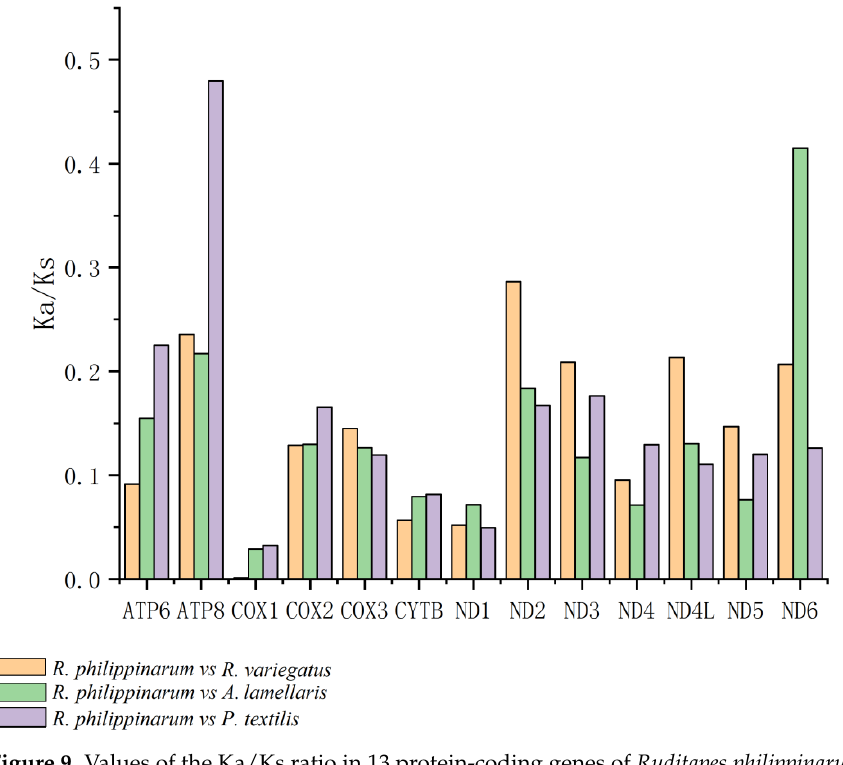
Figure 9. Values of the Ka/Ks ratio in 13 protein-coding genes of Ruditapes philippinarum in relation to those of R. variegatus , Antigona lamellaris , and Paratapes textilis.